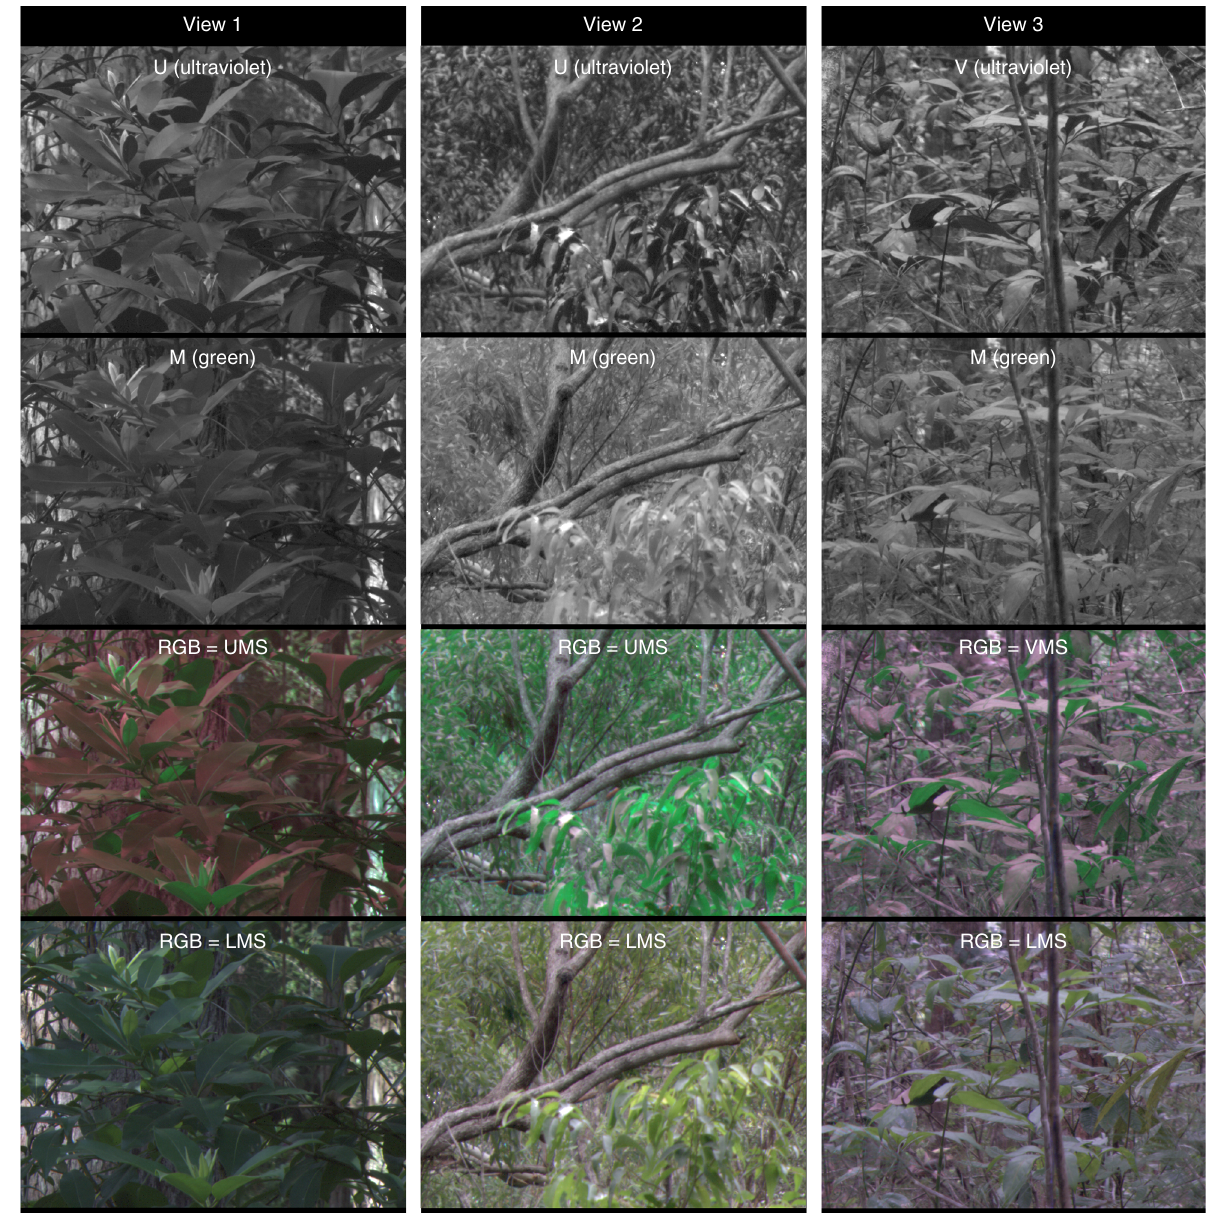
Fig. 3 Example images showing the difference in leaf-contrast seen by the UV- and green-cones in wet schlerophyll habitats in Queensland, Australia. See Fig. 2 legend for further